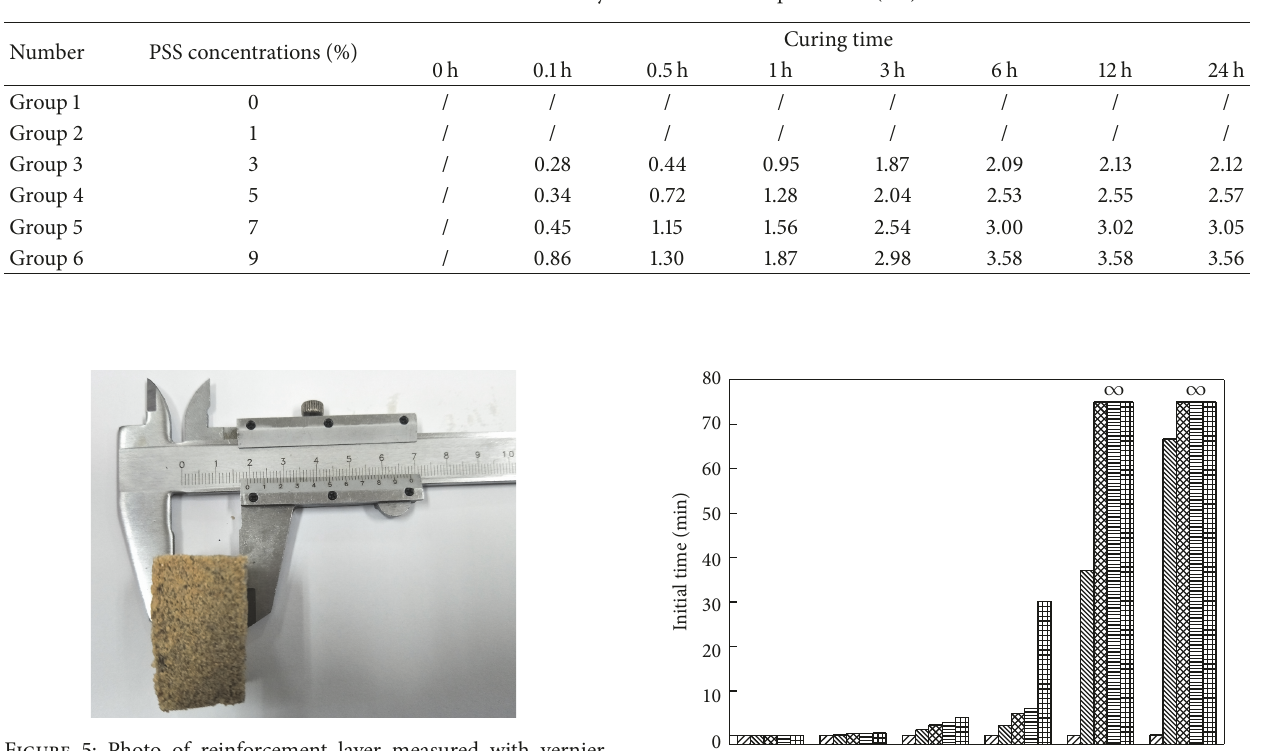
Table 1: The reinforcement layer thickness of samples tested (cm).